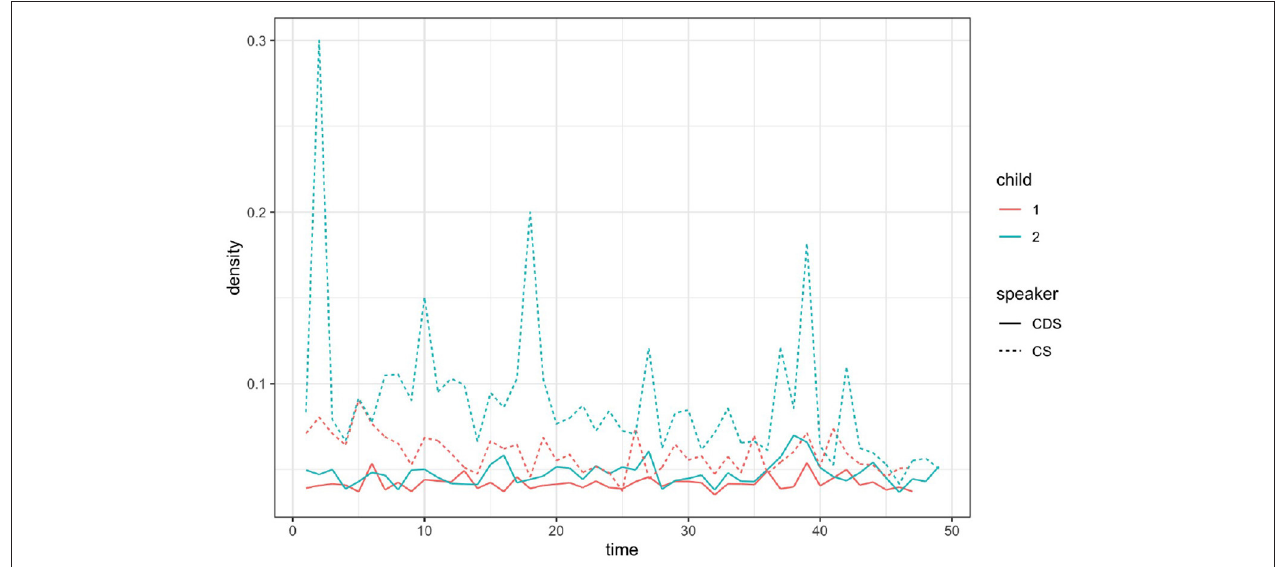
FIGURE 6 | Network density by session, Child 1 and 2, CS and CDS. CS of Child 1 is represented by a dashed red line; CS of Child 2 is represented by a dashed green line; CDS of Child 1 is represented by a solid red line; CDS of Child 2 is represented by a solid green